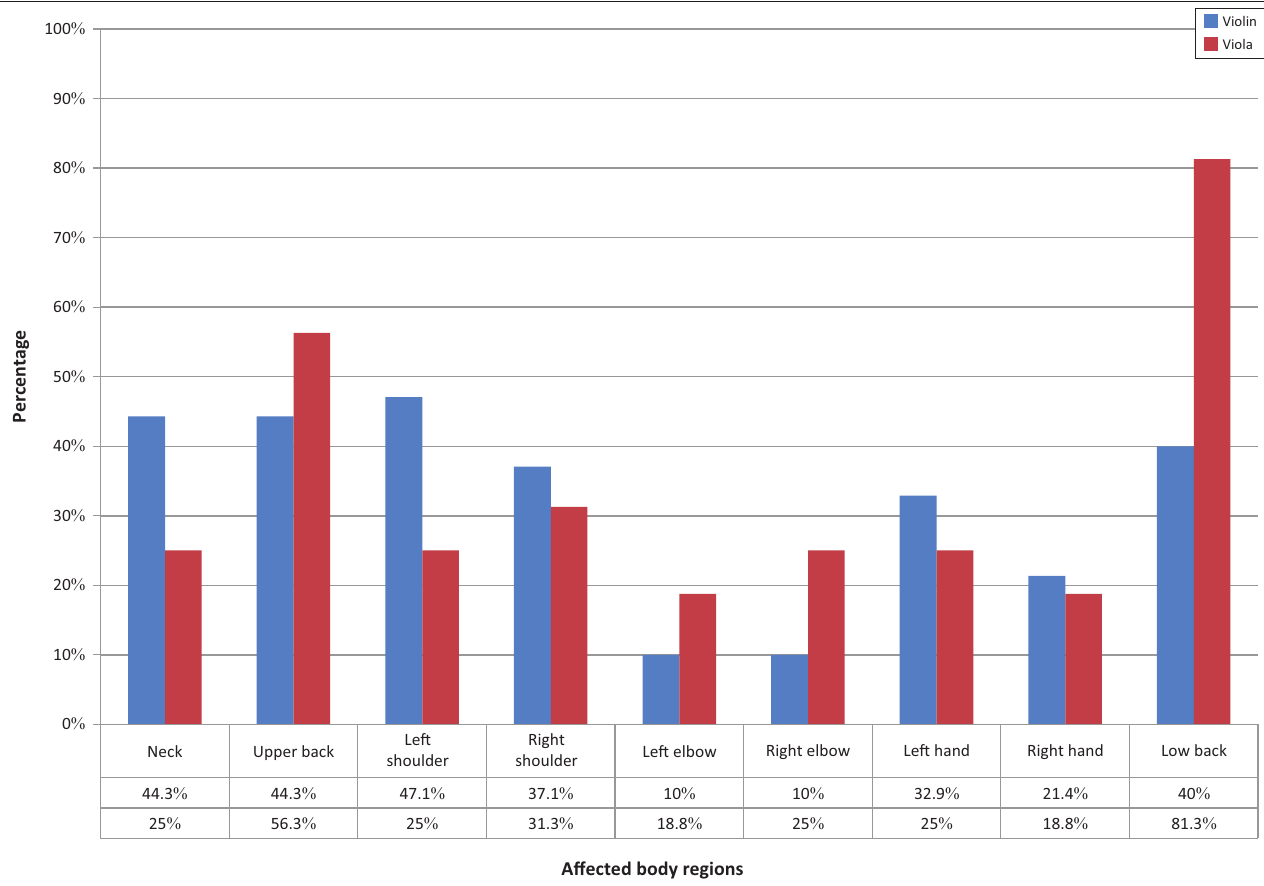
FIGURE 2: Distribution of musculoskeletal problems in the nine anatomic regions in upper string